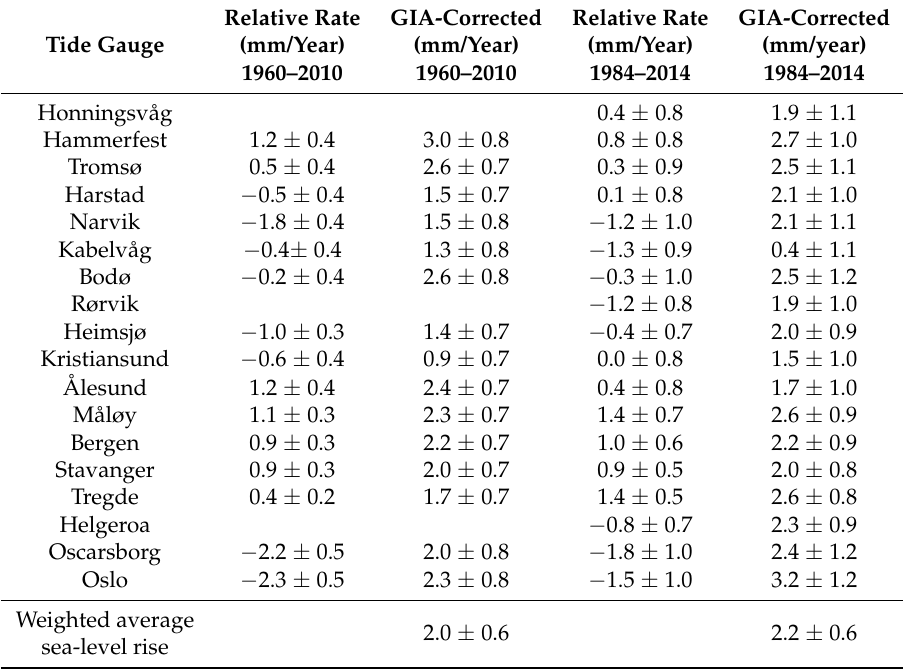
Table 2. Observed relative sea-level rates and rates corrected for glacial isostatic adjustment (GIA) for selected Norwegian tide gauges, ordered along the coast from north to south. To determine the GIA-corrected sea-level rates, we adjusted the tide-gauge observations using (1) vertical land motions estimated from a combined analysis of levelling and Global Navigation Satellite System data, and (2) geoid changes generated using a GIA model [1]. Weighted averages of the rates are given for each period. The standard errors of the GIA-corrected rates and the weighted averages include uncertainties introduced by vertical land motion, geoid corrections and reference frame errors. Records with too short duration or with significant data gaps are excluded from the